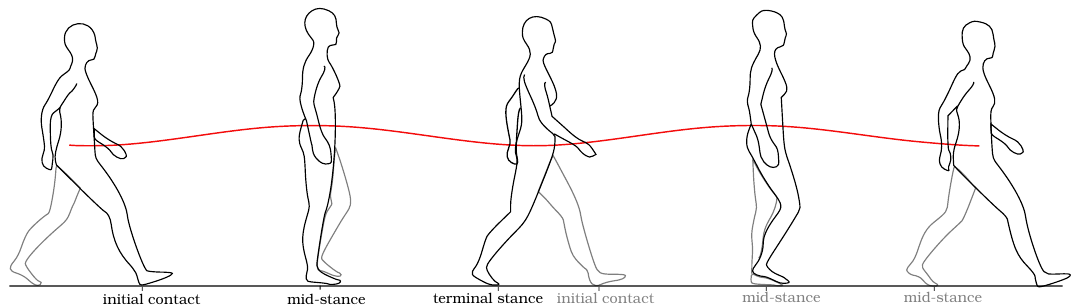
Figure 2. The body center of mass vertical trajectory during a gait